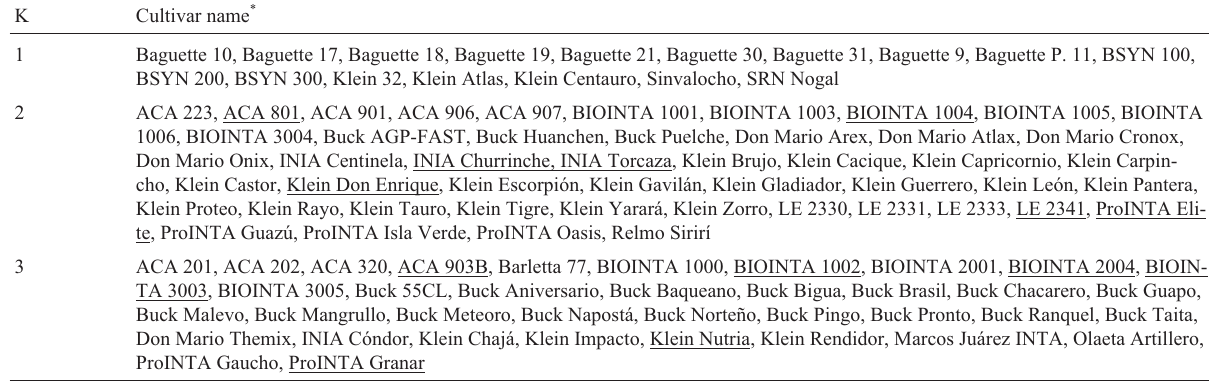
Table 2 - Distribution of 102 Argentinean wheat cultivars in the three subpopulations detected using a model-based